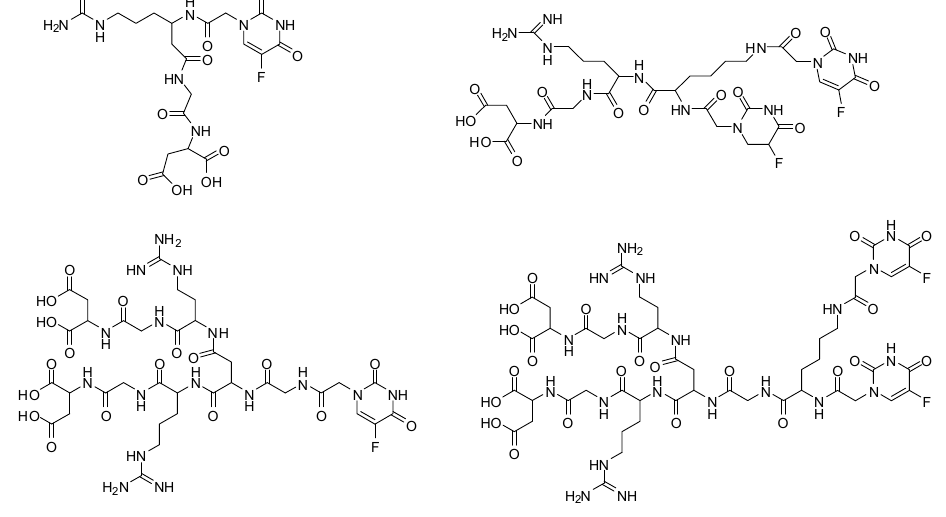
14 of 21 Figure 18. Targeted dendrimer prodrug synthesized by Pan and coworkers [75]. According to Kojima and colleagues [78,79] “metastatic cancer cells degrade extracellular matrices containing collagen”. This information was useful toward designing new prodrugs embedded in collagen gels potentially active in cancer. Thus, the doxorubicin derivatives were synthesized with different surfaces, for instance, collagen peptides and polyethylene glycol. Additionally, prodrug comprising linear poly(glutamic acid) was considered. The compounds showed differences concerning efficiency and selectivity, probably, related to their chemical structure diversity. Additionally, the authors pointed out the importance of these dendrimer prodrug/collagen hybrid gel, since these compounds decreased tumor growth, as well as reduced metastatic activity in vivo . Janus dendrimers are composed by two dendrons with different types of functional groups located at periphery, and/or the core, and/or inner layers. Thus, those dendrimers may be helpful for improving the pharmacokinetic properties, due to the attachment of several molecules, such as